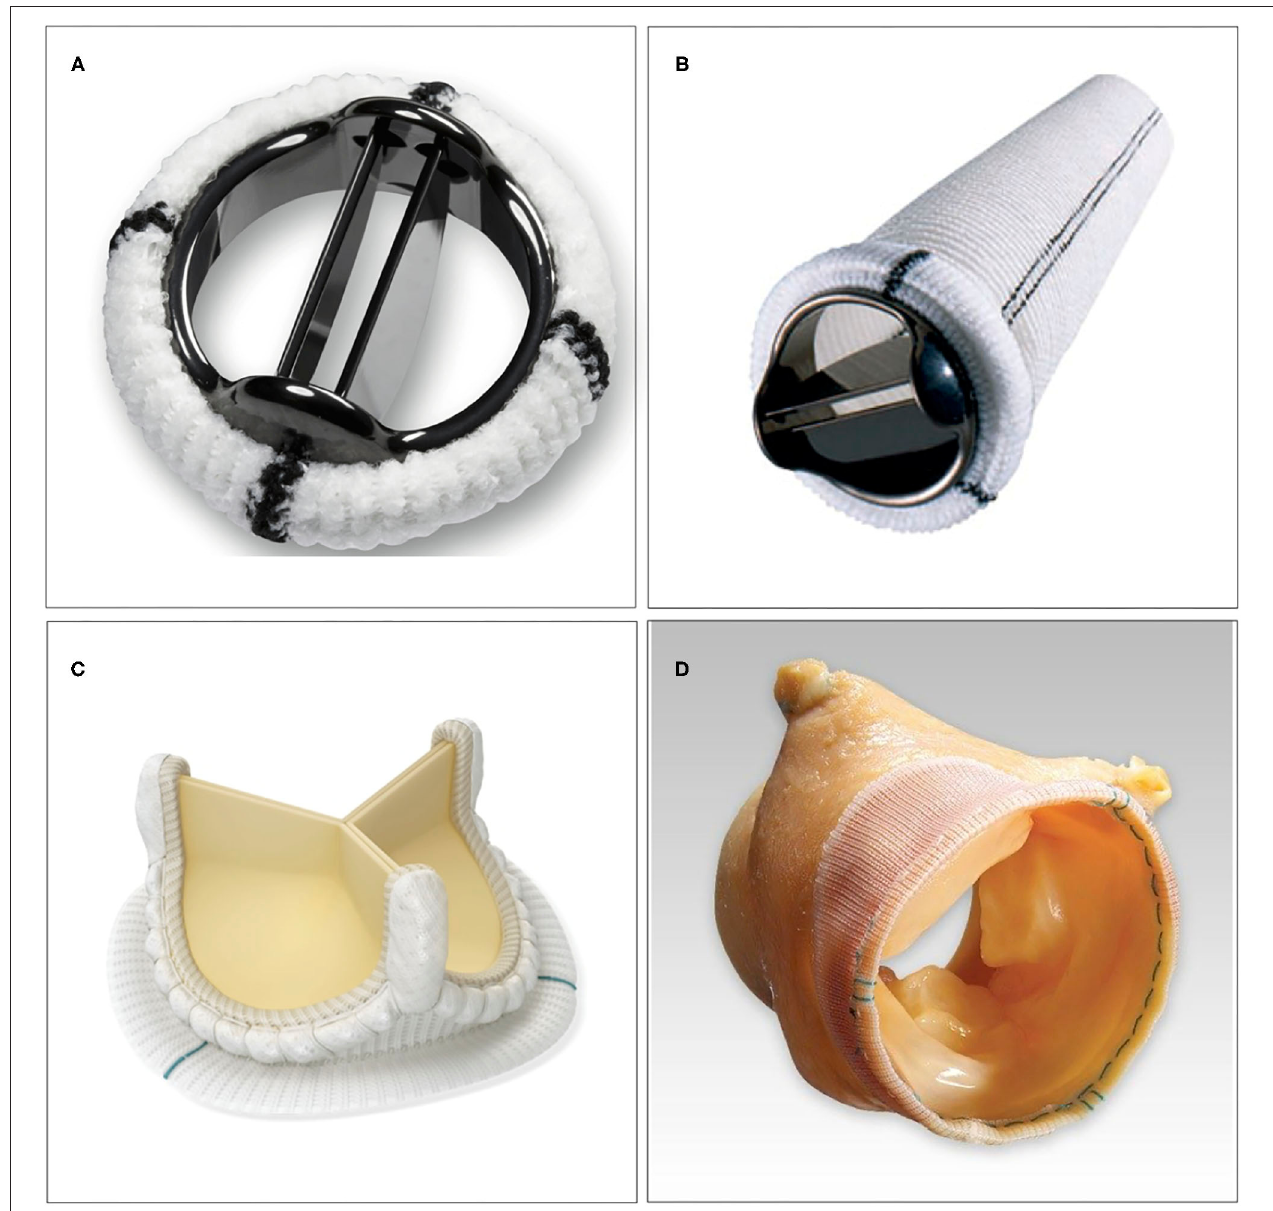
FIGURE 2 | Examples of surgical aortic valve interventions. (A) Bi-leaflet mechanical prosthesis. (B) Mechanical composite graft used in aortic root replacement. (C) Stented bioprosthetic valve (Avalus TM , Medtronic, MN, USA). (D) Stentless bioprosthetic valve (Freestyle TM , Medtronic, MN, USA).